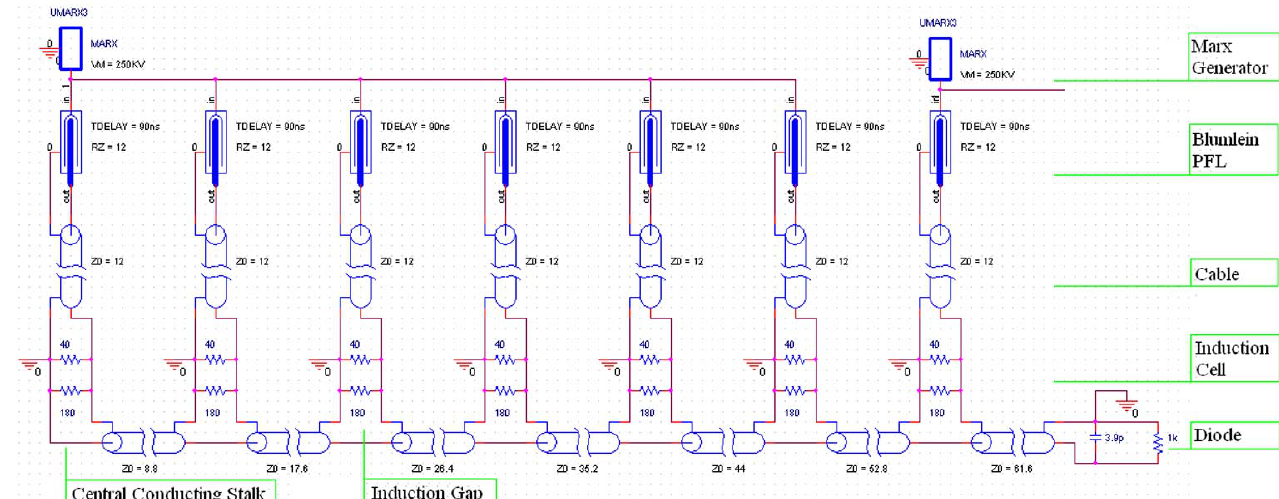
FIG. 3. (Color) Electrical schematic diagram of the injector (cathode side).